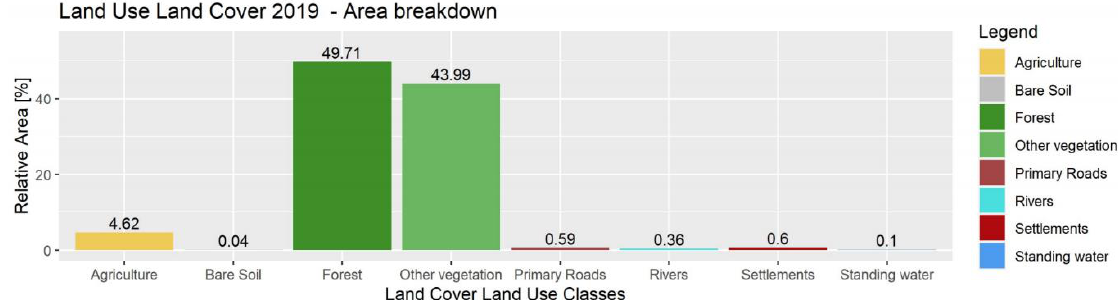
Figure 14. Breakdown of the area of land cover land use classes for the 2019 epoch.